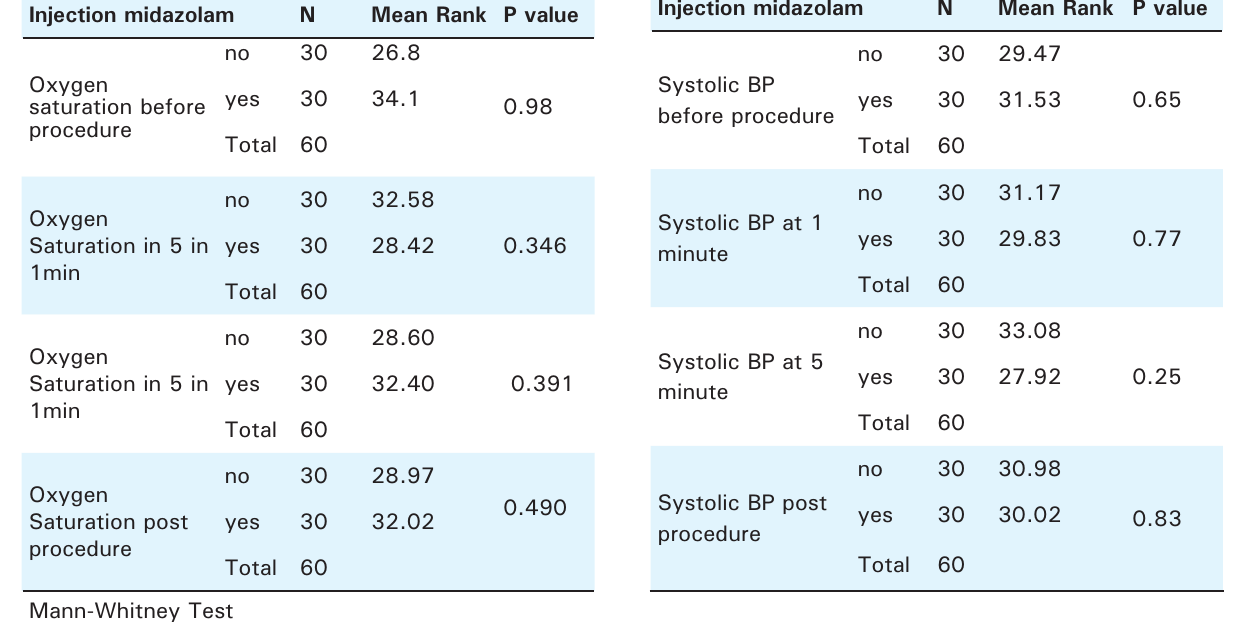
Table 2. Showing no signifi cant changes in pulse rate among two groups Injection midazolam